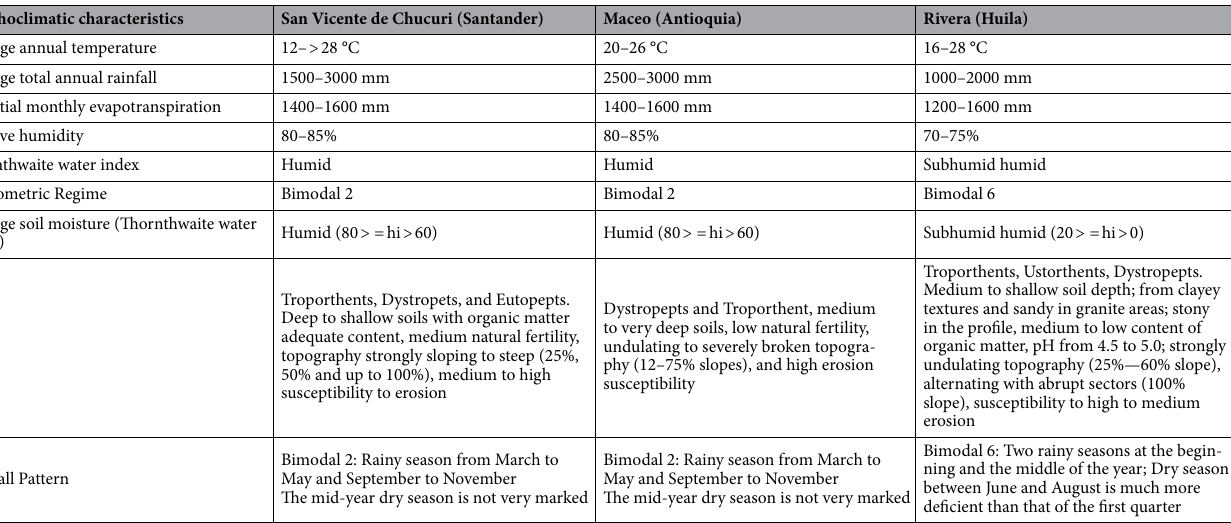
Table 2. Edaphoclimatic characteristics of the three study locations. Source: IDEAM 56 , Gómez et al. 57